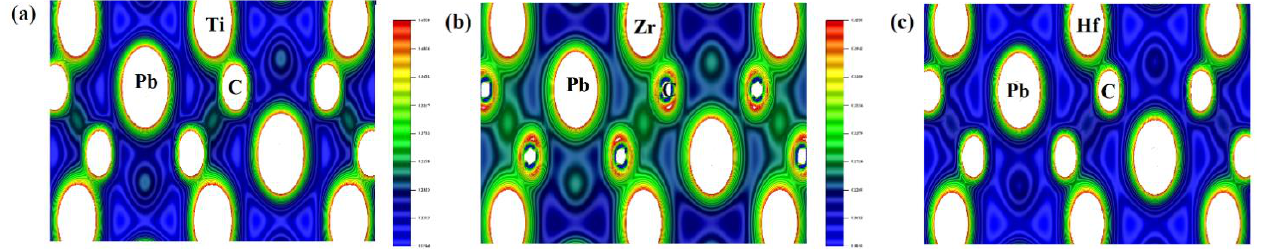
Figure 11. The electron density maps for ( a ) Ti 2 PbC, ( b ) Zr 2 PbC, and ( c ) Hf 2 PbC in (11–20) plane.